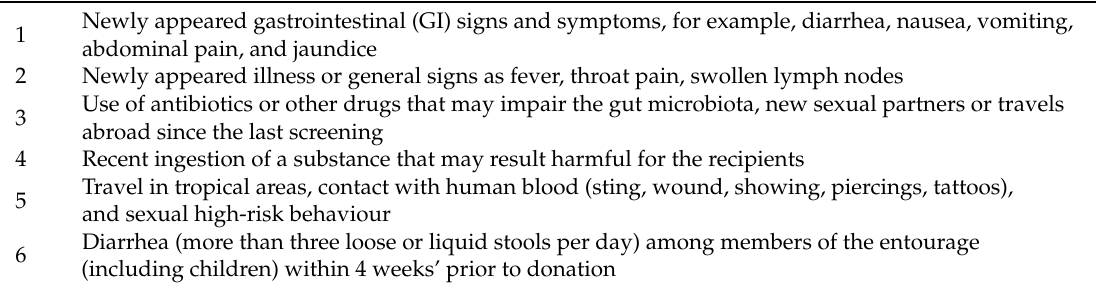
Table 2. List of key issues to select confirm donors at the donation day